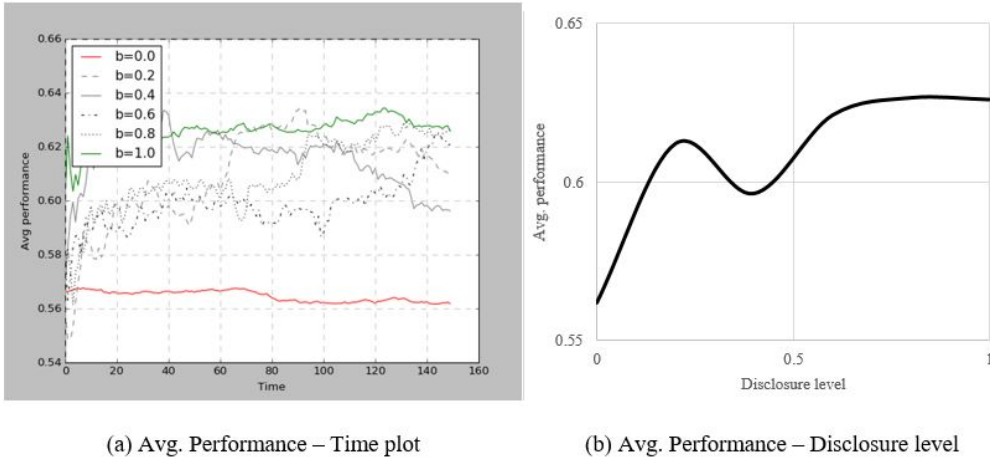
Figure A1. Average performance result of ‘no feedback policy’ condition model.